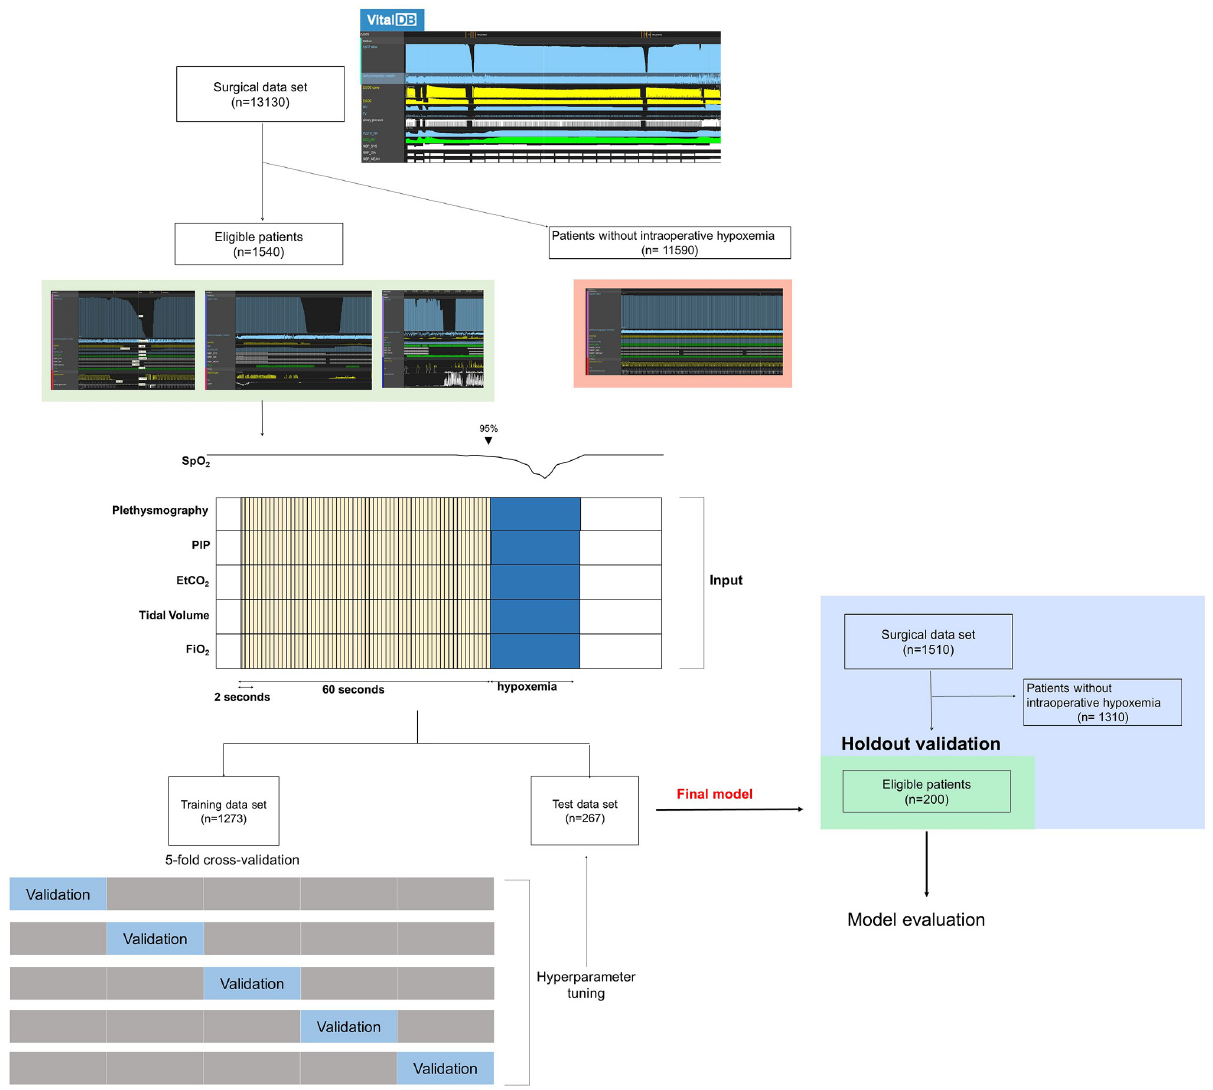
Fig 1. Flow chart presenting patient selection and data analysis. PIP, Peak Inspiratory Pressure; EtCO 2 End tidal CO 2 ; FiO 2 , Fraction of inspired oxygen.